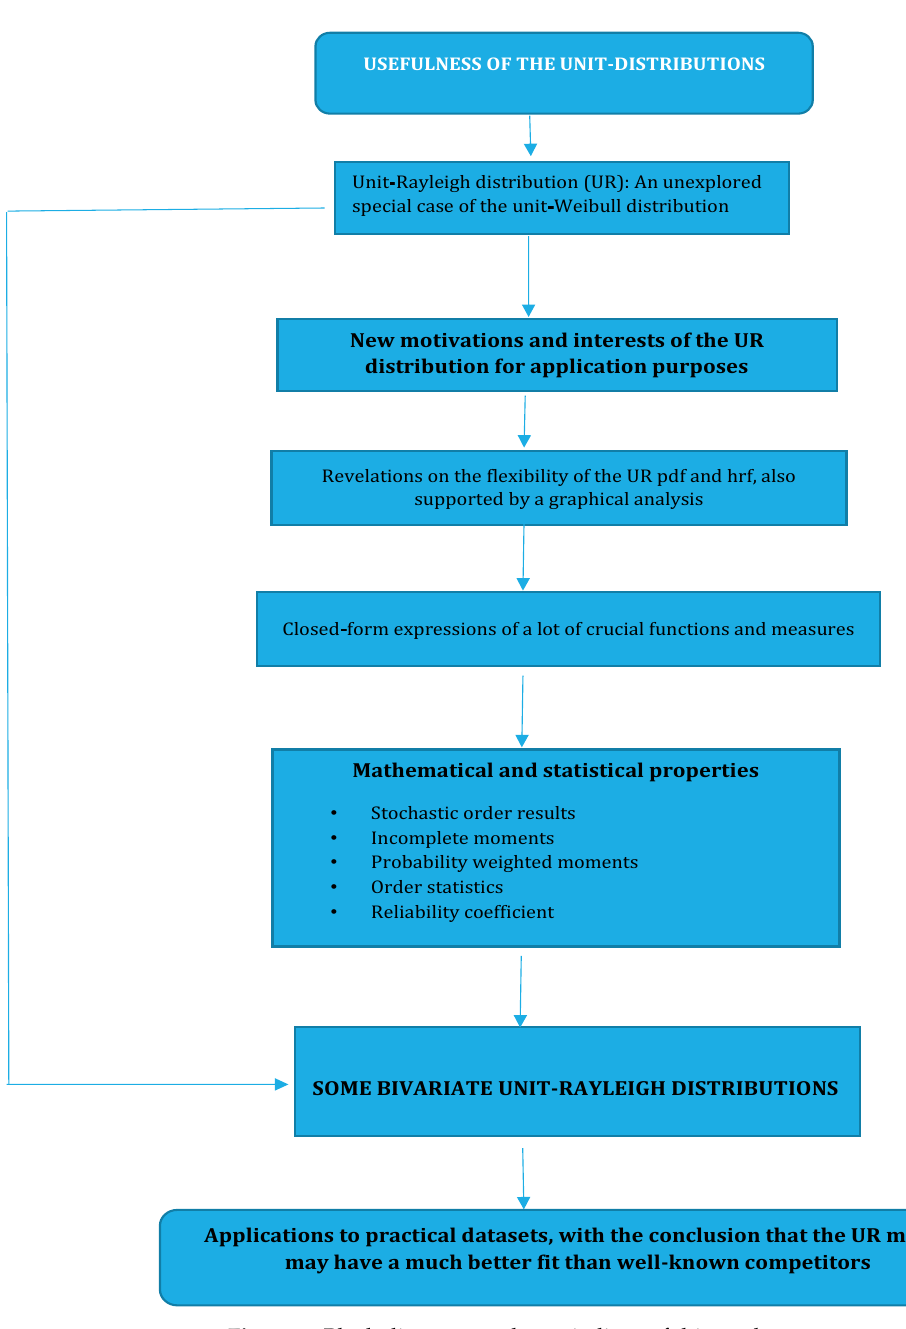
Figure 1. Block diagram on the main lines of this